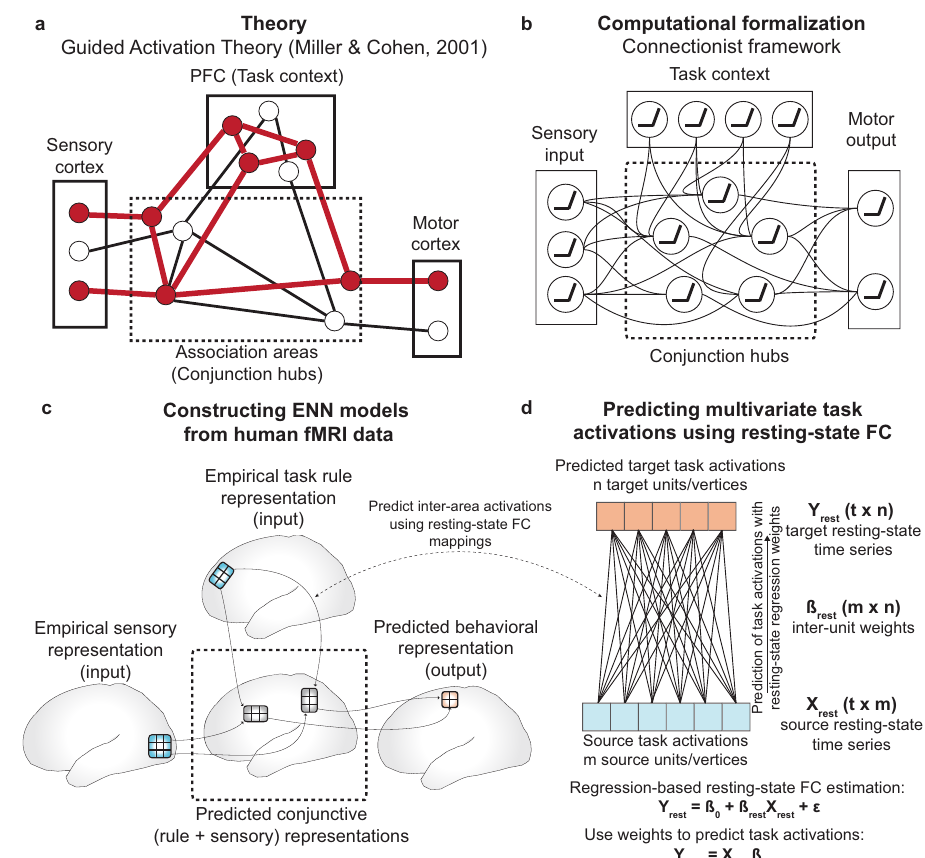
Fig. 1 Leveraging the Guided Activation Theory to inspire ENN models of cognitive computation during task-based fMRI. a A modi fi ed version of the Guided Activation Theory of prefrontal cortex, highlighting a potential key role for conjunction hubs. The Guided Activation Theory posits that sensory cortices (left), which contain sensory stimulus-related activations, and prefrontal areas (top), which contain task context/rule activations, integrate in association cortex to produce conjunctive activations through patterns of guided activations. Conjunctive activations are then guided to motor areas to generate motor response activations for task behavior. b The Guided Activation Theory can be reconceptualized in a connectionist framework. This provides a formalization of how fl exible sensorimotor transformations may be implemented computationally. The formalization involves the task context and sensory stimuli representing the input layer, the association units representing a hidden layer, and the behavioral (motor) responses as the output layer. c Testing the Guided Activation Theory using task fMRI data collected in humans during context-dependent tasks. Using quantitative methods, we empirically test how different task activations (e.g., sensory stimuli and task context) form conjunctive activations to produce motor response activations using activity fl ow mapping 18 . d The Guided Activation Theory can be empirically tested by projecting task activation patterns between brain areas by estimating inter-area FC weight mappings obtained from resting-state fMRI data. Based on the activity fl ow principle 18 , we estimated inter-vertex mappings using regression (see Methods) on resting-state fMRI data. This approach identi fi es a projection that maps across distinct spatial units (i.e., vertices) in empirical data, similar to how inter-layer weights propagate activity across layers in an